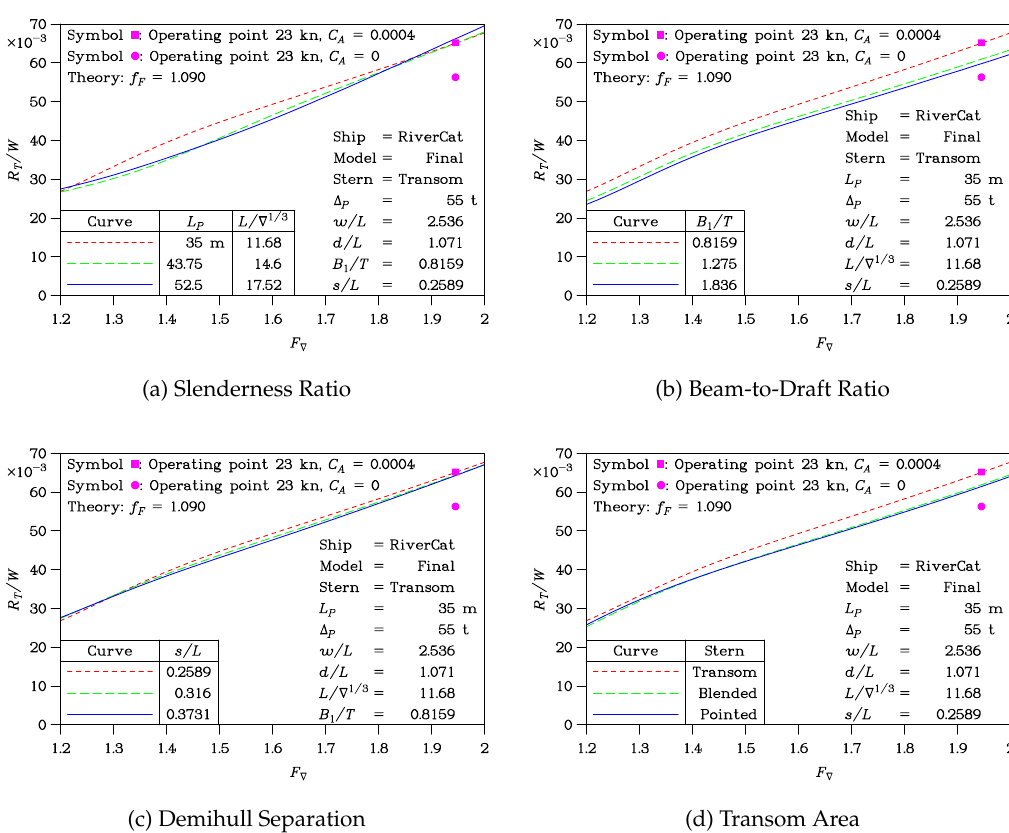
Figure 11. Influence of Affine Transformations on Prototype Resistance Table 3. Transport Factor of Sydney RiverCat